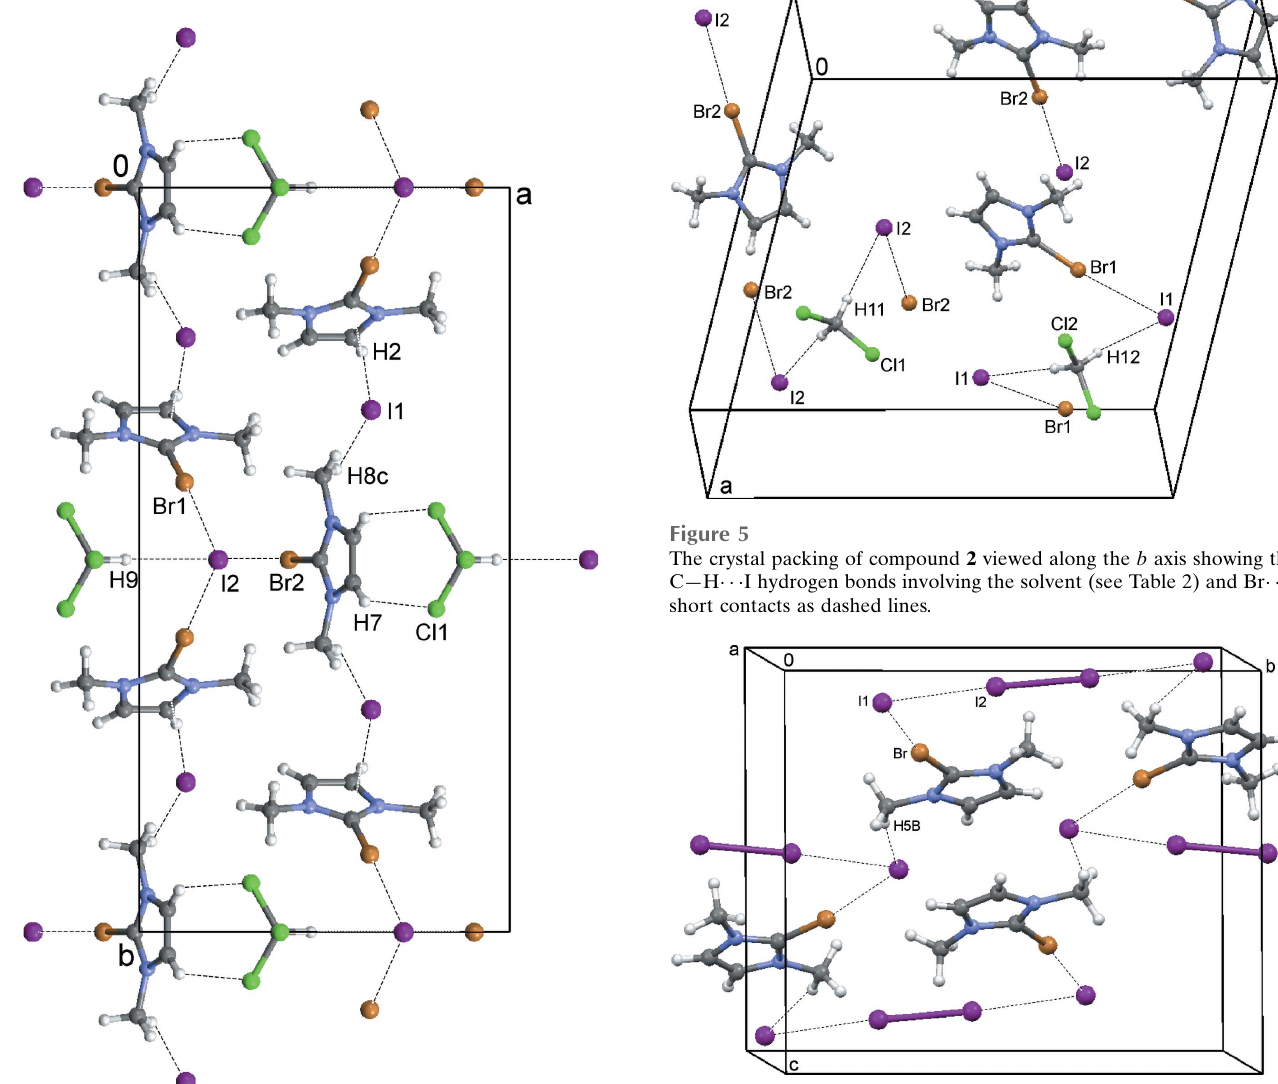
Figure 6 The crystal packing of compound 3 viewed along the a axis showing the